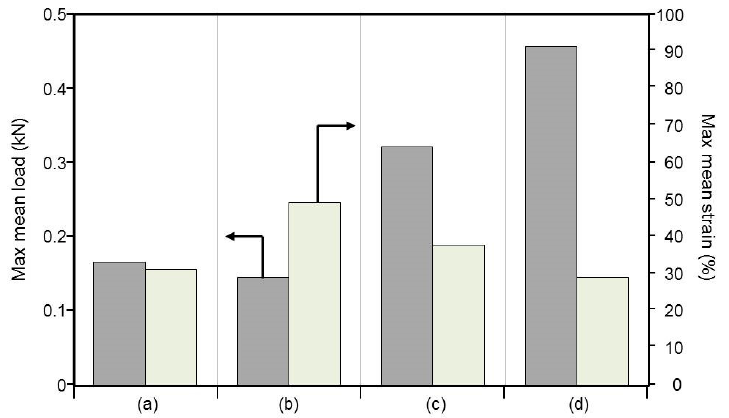
Figure 11. Max mean load (kN) and strain (%) of braided ropes prepared from PLA fiber: ( a ) core fiber prepared from original PLA fiber; ( b ) P-3 braided rope without core fiber; ( c ) P-3 braided rope with single-core fiber, and ( d ) P-3 braided rope with double-core